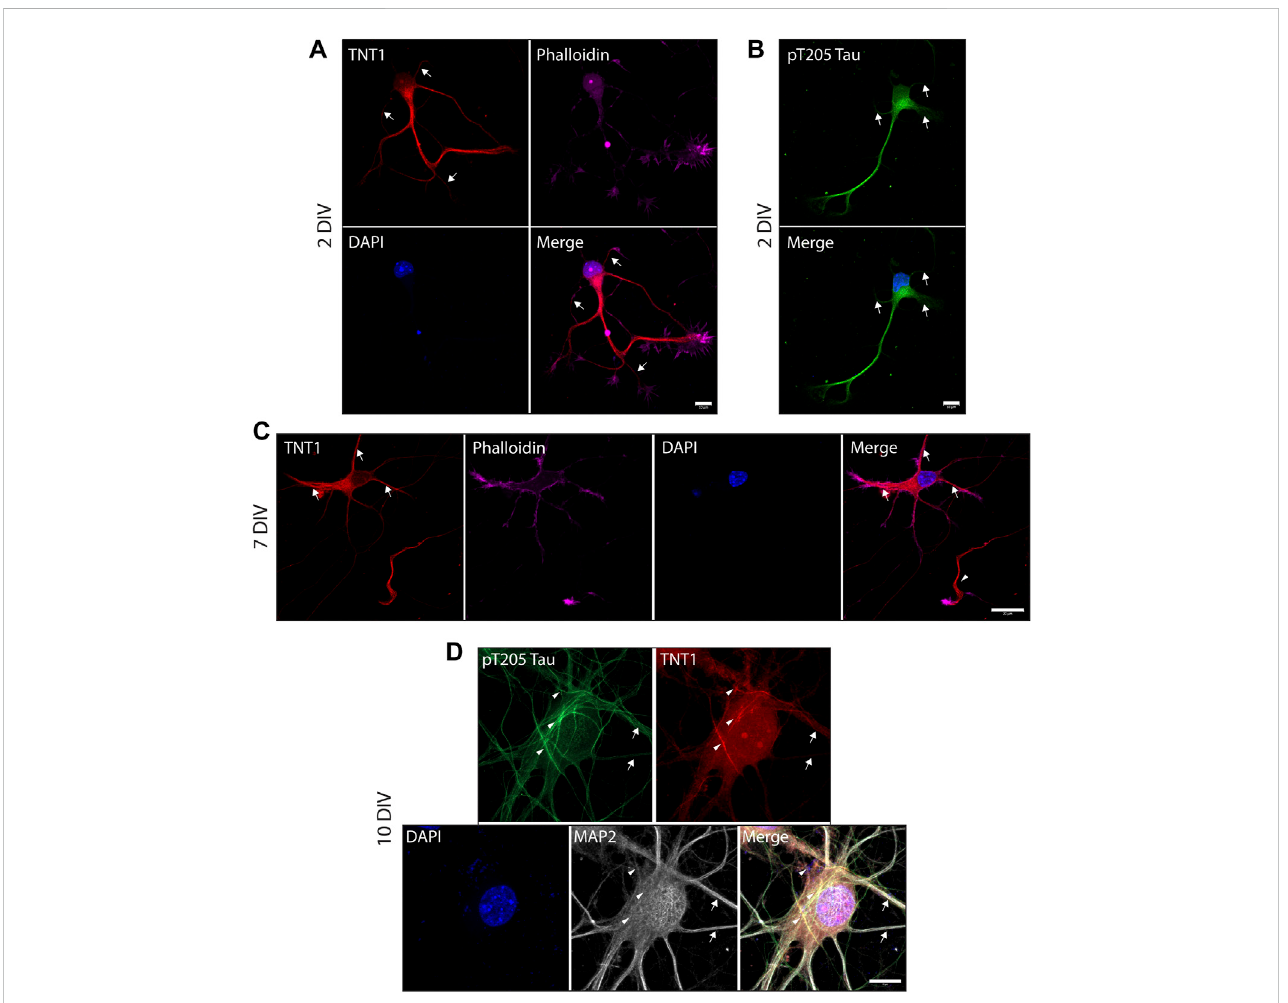
PAD exposure and pT205 tau localization changes and becomes progressively more restricted through neuronal development. WT hippocampal neurons cultured for 2 (A, B) , 7 (C) , or 10 DIV (D) were stained for TNT1 (red) and/or pT205 tau (green), actin (phalloidin; magenta), and MAP2 (white). At 2DIV TNT1 immunoreactivity is visible within the cell body and along the longest neurite. There is less PAD exposure in minor processes and branches ( A , arrows). Similarly, pT205 tau immunoreactivity is equally distributed along the longest neurite and within the cell body but is not enriched in minor processes ( B ,arrows).At7DIV,TNT1immunoreactivityisobservedinthecellbodyandattheendofthelongestneurite( C ,arrowhead)aswellasinsomeminorprocesses ( C , arrows). By 10DIV, PAD exposure and pT205 tau are localized to potential synaptic sites. pT205 tau and PAD exposure are localized are restricted subdomains along the axon at axonal-axonal or axonal-cell body crossing points ( D , arrowheads). Neither pT205 nor TNT1 immunoreactivity is enriched in MAP2-positive dendrites ( D , arrows). Scale bar s : 10 μ m (A, B, D) or 20 μ m (C) .